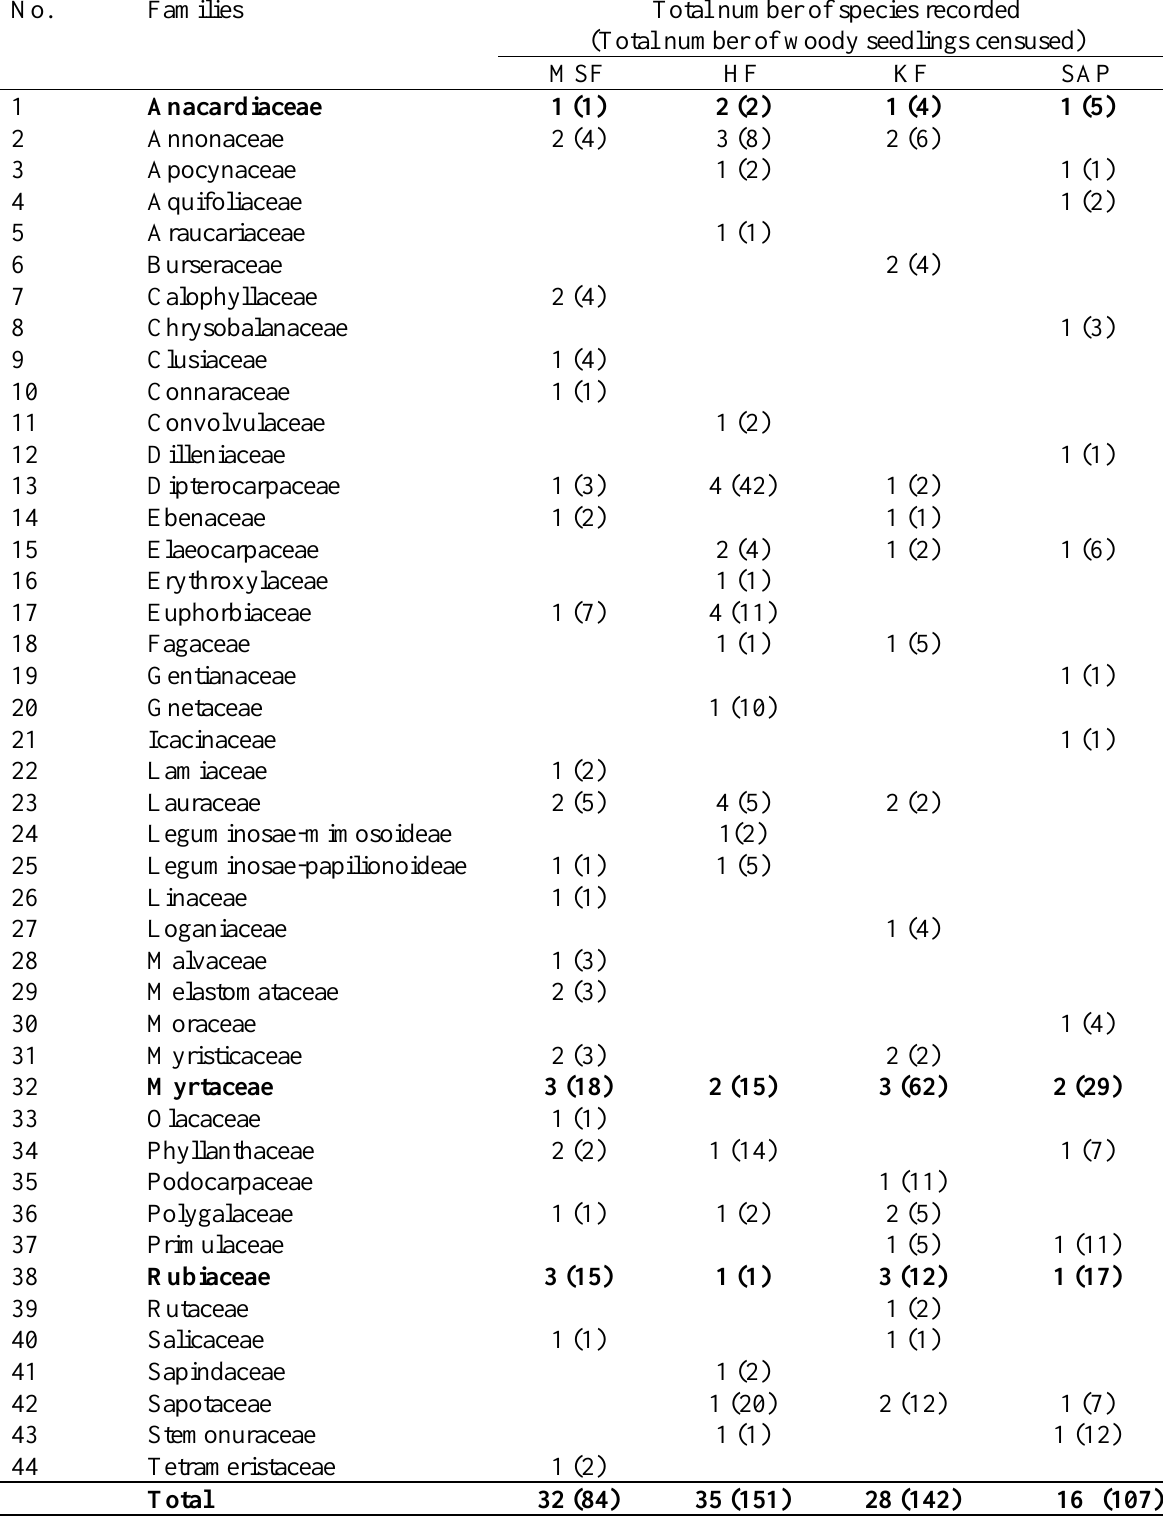
Table 3. Family distribution of censused woody seedlings (50 ≤ height (cm) ≤ 100) across the four forest types: mixed peat-swamp forest (MSF, n = 4 plots), heath forest (HF, n = 6 plots), kerapah (KF, n = 6 plots) and Shorea albida peat-swamp forest (SAP, n = 6 plots). Values for each family are total number of species recorded per forest type (calculated as a total count for all plots per forest type), with the total number of woody seedlings censused per forest type displayed within parenthesis. Families shown in bold are present in all four forest